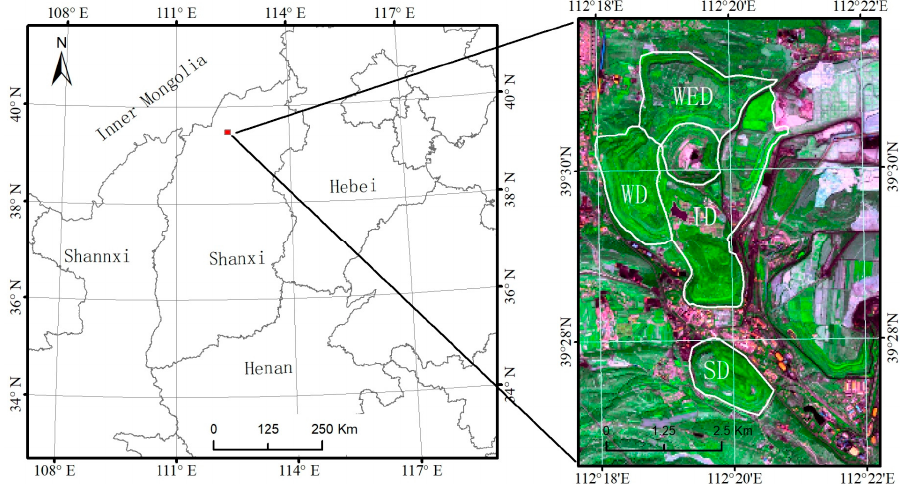
Figure 1. Location of the study area (Shuozhou City, Shanxi Province, 112°10 ′ 58 ″ ~113°30 ′ E, 39°23 ′ ~39°37 ′ N). 39 ◦ 23 (cid:48) ~39 ◦ 37 (cid:48)